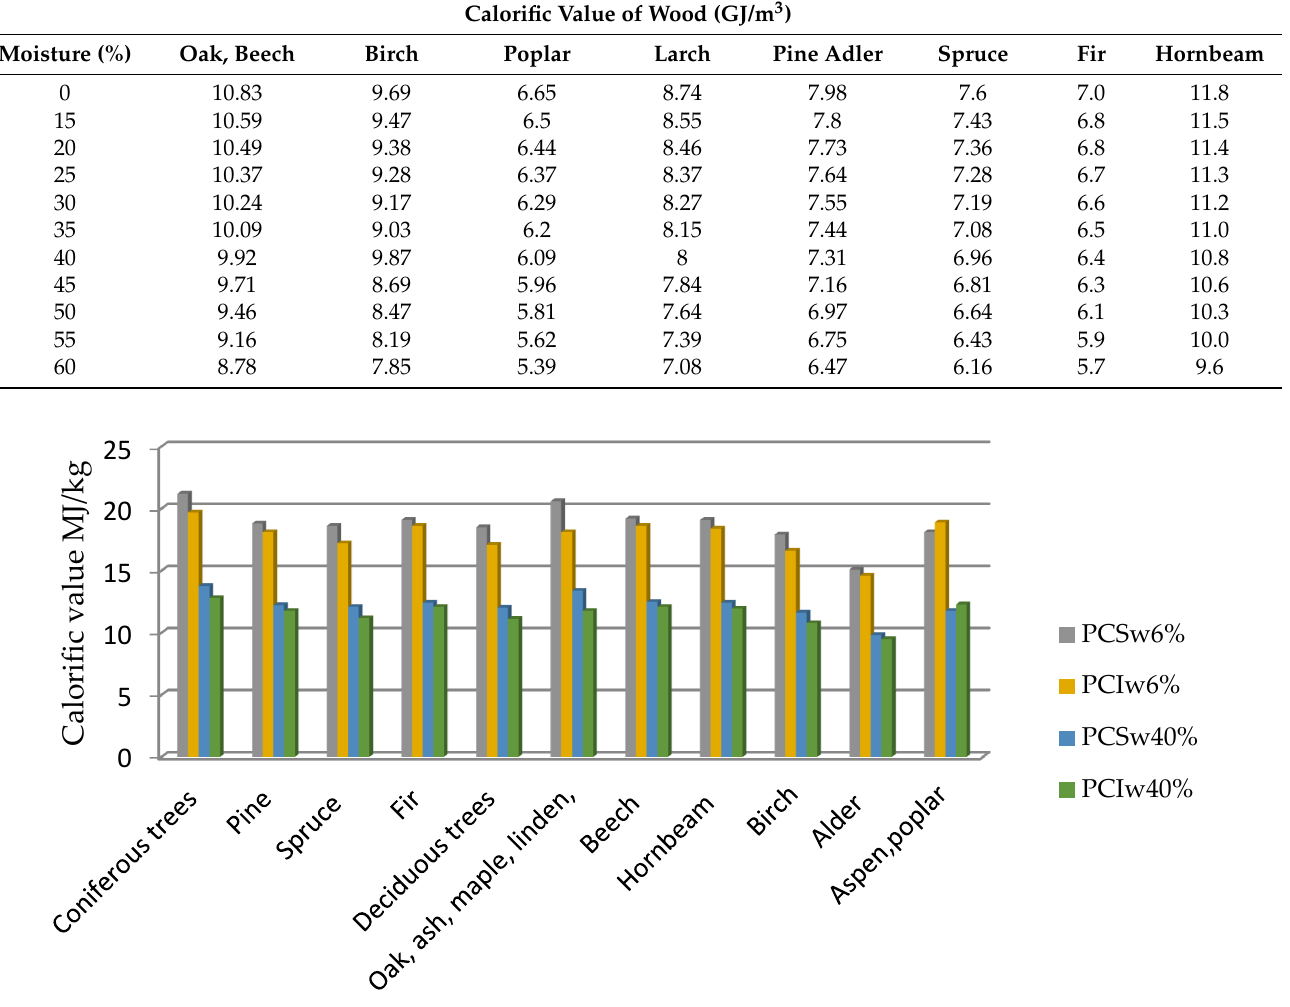
Figure 3. Variability in the calorific value of species on a density scale [109–115].